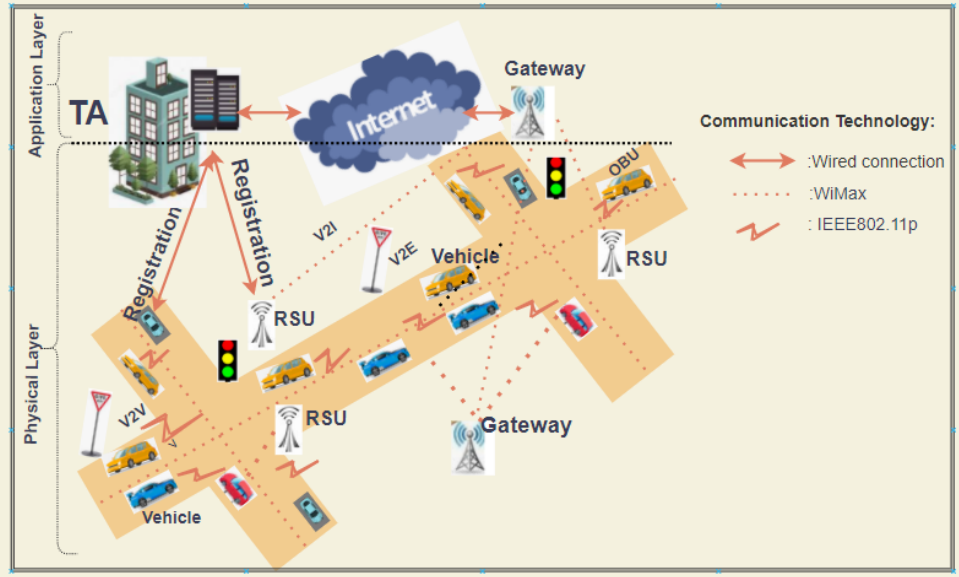
Figure 1. Two Layered Vehicular Ad hoc networks (VANETs)